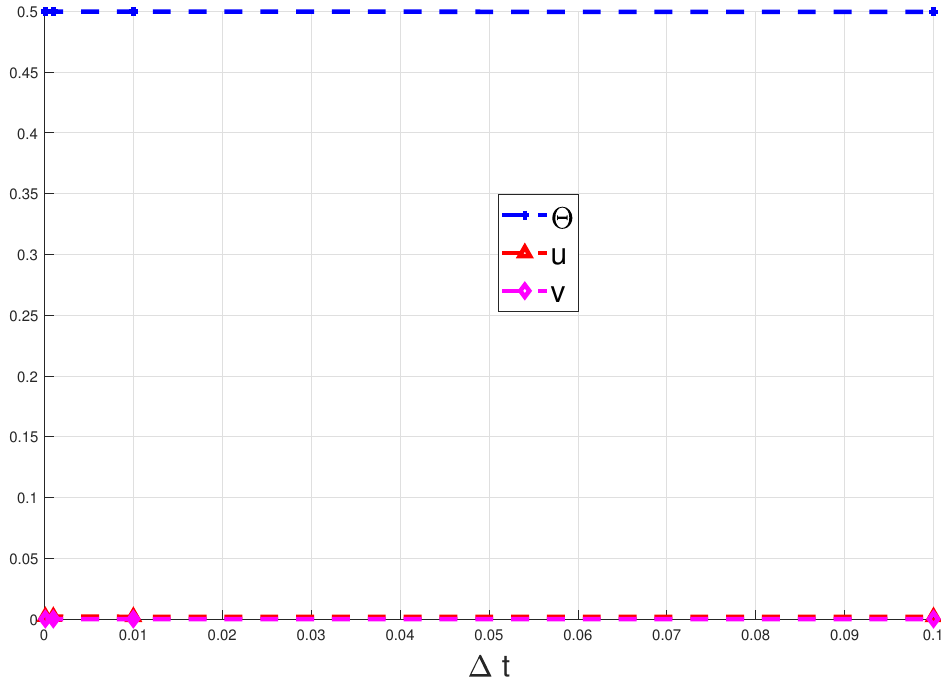
Figure 3. Illustration of time-step size independence at mid-point of the domain and t =